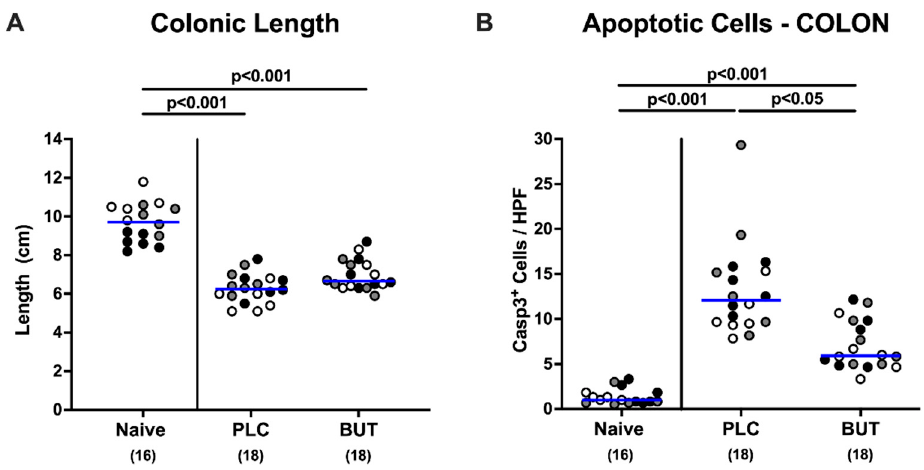
Figure 4. Colonic lengths and apoptotic cells in colonic epithelia upon oral butyrate treatment. Following gut microbiota depletion, IL-10 − / − mice were challenged with C. jejuni strain 81–176 by oral gavage on days 0 and 1. Starting from day 2 p.i., the animals were subjected to butyrate (BUT) or placebo (PLC) via the autoclaved tap water ad libitum. Naive mice served as uninfected and untreated controls. After the sacrifice of the mice on day 6 p.i., ( A ) colonic lengths were measured and ( B ) apoptotic epithelial cells were counted in each colonic paraffin section after immunohistochemical staining with anti-cleaved caspase3 (Casp3 + ). The mean of six counts out of representative high- power fields (HPF, 400-fold magnification) per individual mouse was applied. Differently colored circles indicate data from three individual experiments. Medians (blue bar), significance levels ( p values) evaluated by the ANOVA test with Tukey post-correction or by the Kruskal–Wallis test and Dunn’s post-correction, and total numbers of included animals (parentheses) are shown.